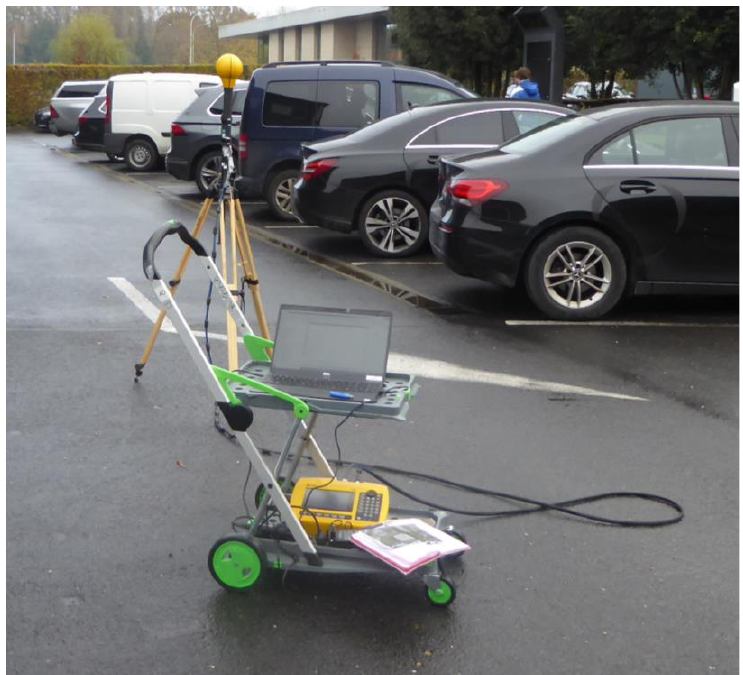
Figure 2. Second type of equipment used in this study to measure the exposure to 5G new radio base stations, consisting of a Narda SRM-3006 field strength analyzer (SRM) and a tri-axial isotropic antenna (“probe”).